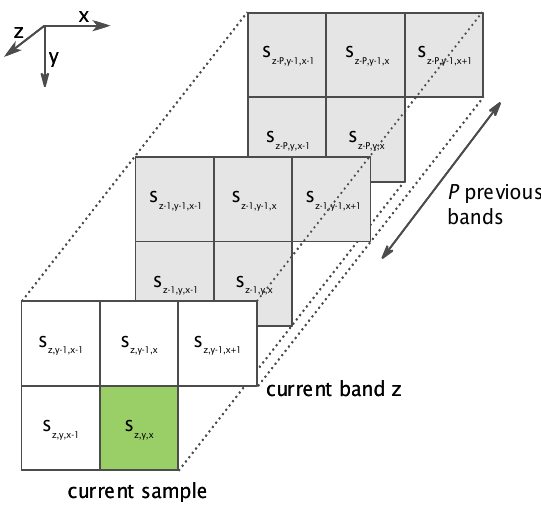
Figure 1. Sample neighbourhood considered for